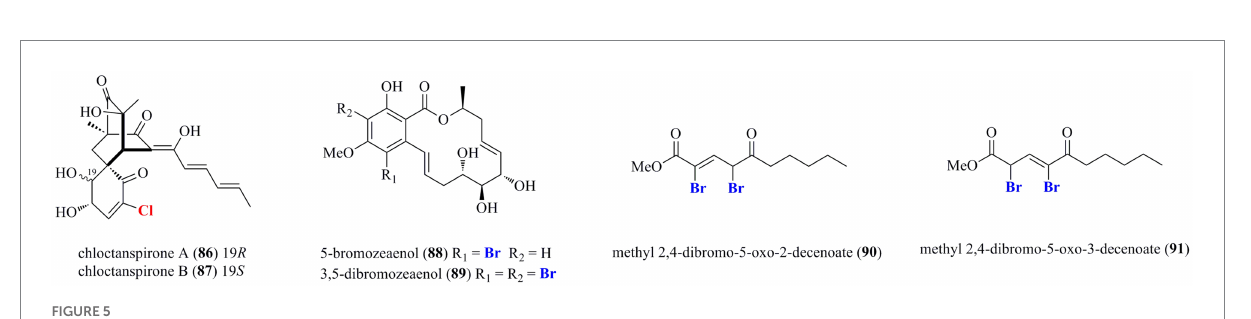
FIGURE 5 Other halogenated polyketides from marine-derived fungi ( 86–91